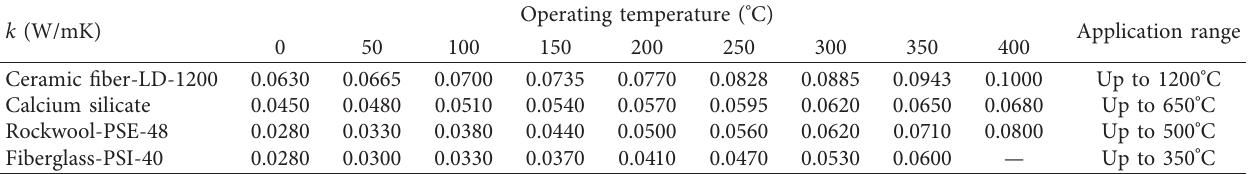
Table 1: Thermal conductivity as a function of operating temperature and application range for each type of thermal